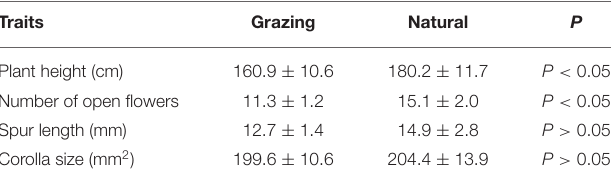
TABLE 2 | Phenotypic correlations among the traits of C. microphylla based on the grazing plants (above the diagonal) and natural plants (below the diagonal). Plant height Number of opening flowers